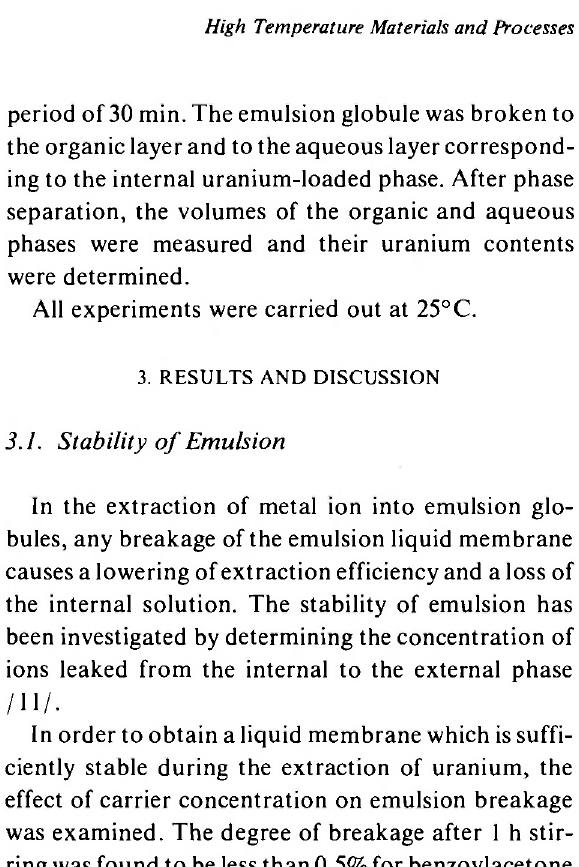
Fig. 1: Experimental proceduresfor emulsion liquid membranes.